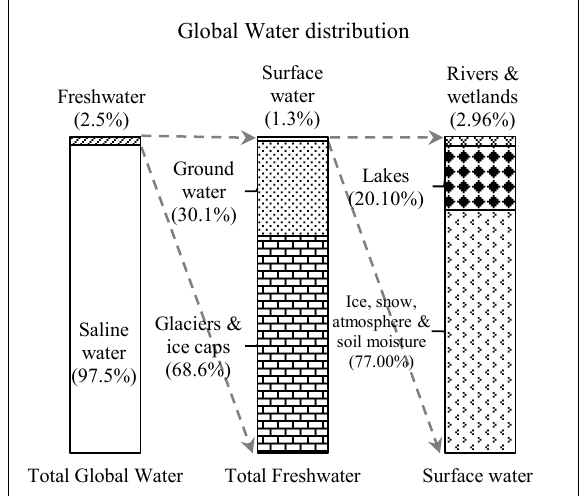
Figure 1: Total available water resources in the world, information collected from Shiklomanov IA